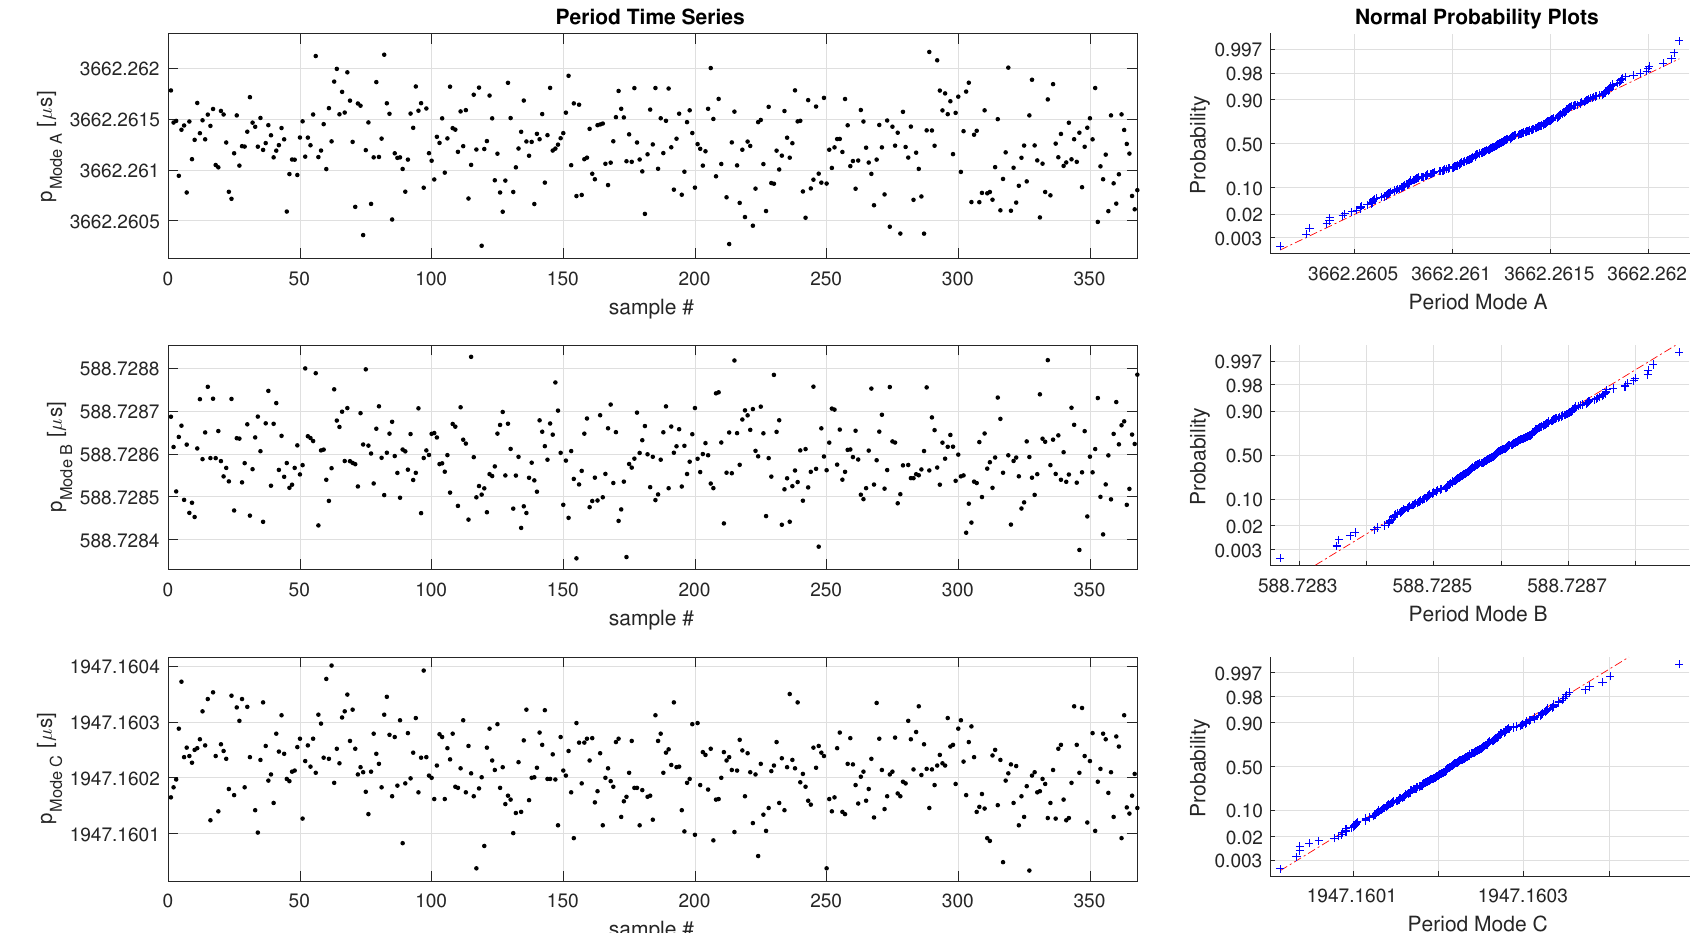
Figure 6. Period data, simultaneous measurement of three modes, U-tube filled with